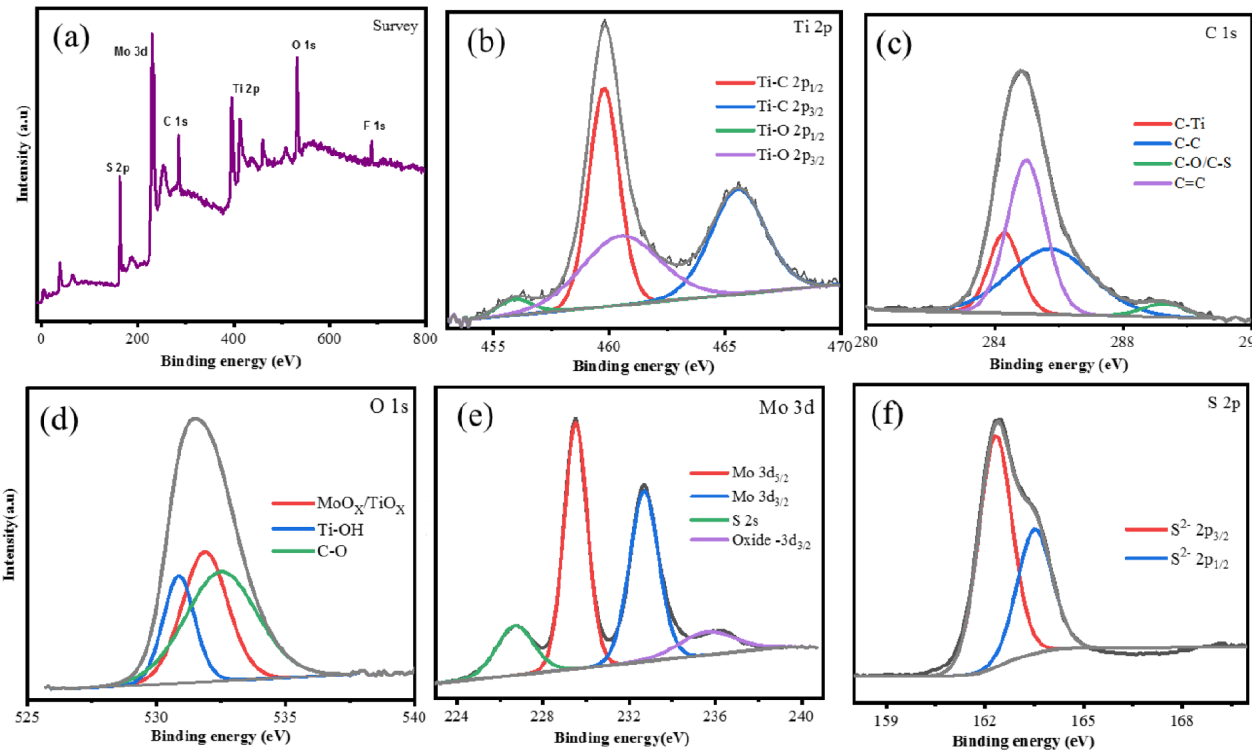
Figure 15. XPS for the ( a ) Survey; ( b ) Ti 2p; ( c ) C 1s; ( d ) O 1s; ( e ) Mo 3d and ( f ) S 2p region for